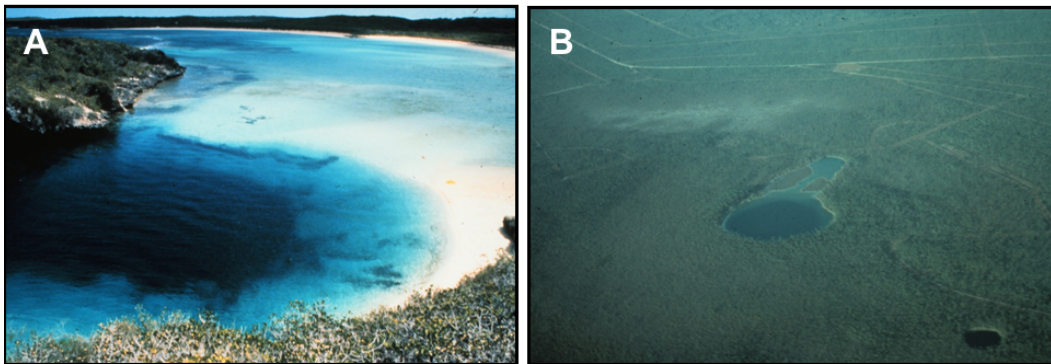
Figure 9. Blue holes in the Bahamian Archipelago. ( A ) Dean’s Blue Hole, an ocean hole on Long Island, Bahamas, connected to the open sea by a shallow lagoon, which has restricted sediment transport that would infill the blue hole. The water column is entirely marine. The depth is 202 m [27]. The blue hole collapse prograded upward to reach the surface, including removing part of an overlying dune ridge (under the letter A). ( B ) Inland blue hole in the interior of North Andros Island. It is protected from marine infill processes and contains freshwater on top of a halocline/mixing zone, which is on top of marine water. Depth is over 30 m. In both (A) and (B), the depth results in a dark blue color; in both cases, shallow adjacent water has the classic light blue color of Bahamian lagoons. Deep progradational collapse blue holes and their associated cave conduit systems are found only on the large Bahama Banks, and not on the very small banks (Table 1) [23]. During glacioeustatic